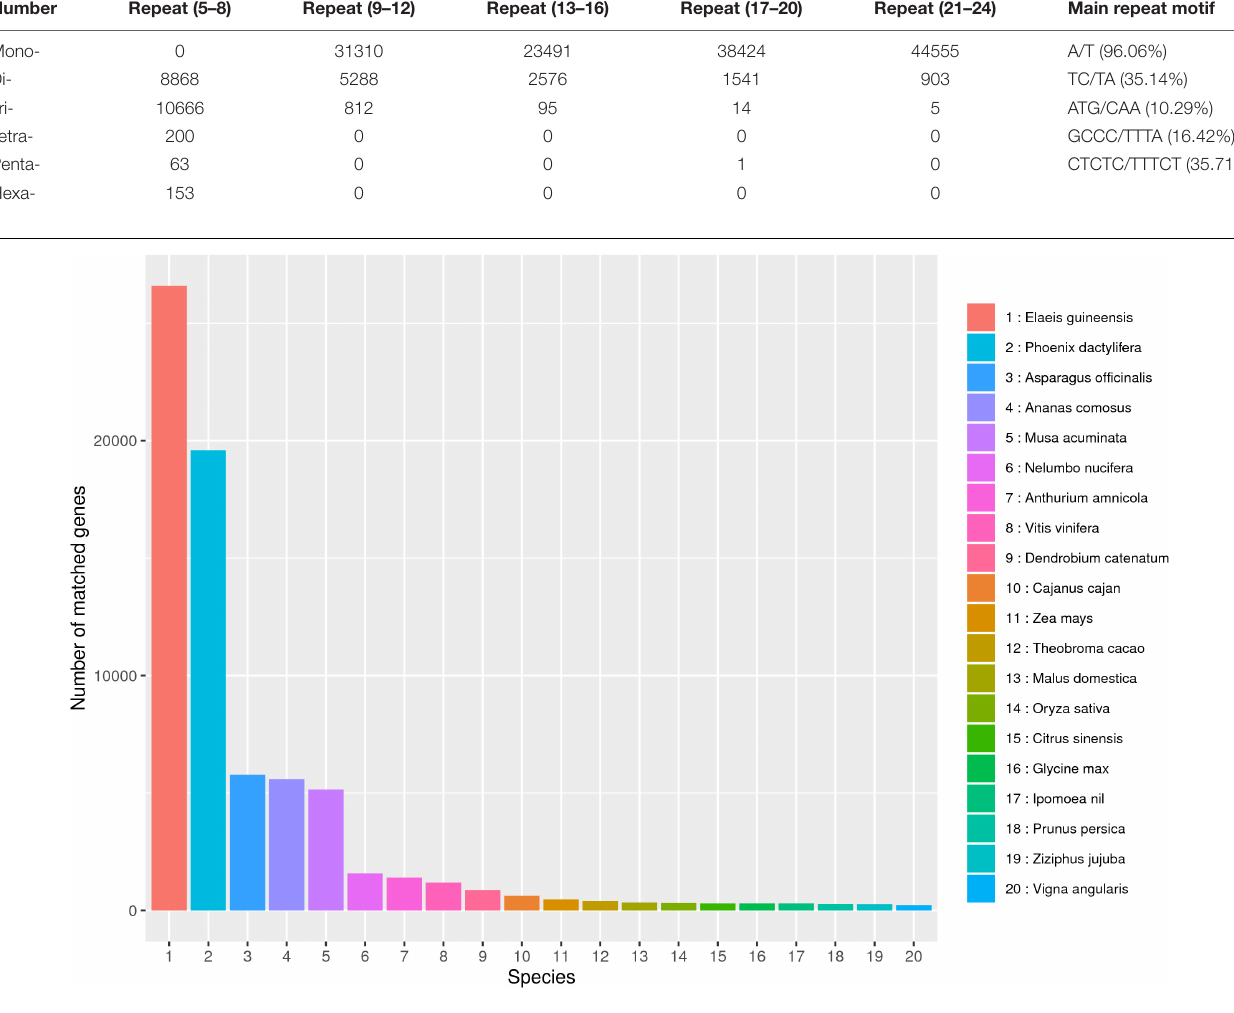
FIGURE 8 | NR database species annotation. A total of 20 species were